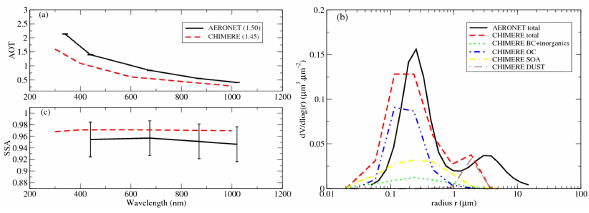
Fig. 6. Wavelength dependence of the (a) AOT and (c) SSA av- eraged over 5–12 August 2010 simulated by CHIMERE with cor- responding AERONET observations over Moscow. Error bars rep- resent the uncertainty range of observations for SSA ( ± 0.03, see Dubovik et al. (2000)) and AOT. Values of the observed and mod- elled Angström exponent are indicated in parenthesis. (b) Column volume size distribution retrieved by AERONET and modelled by CHIMERE for the total aerosol population and for each chemical ± 0.01,